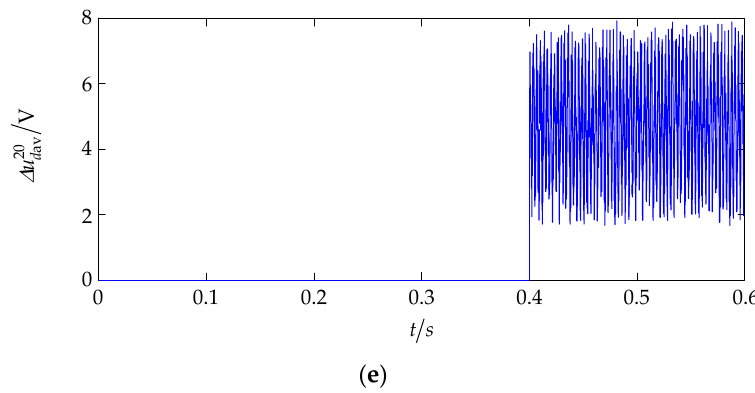
Figure 10. The simulation results (rated load, n ∗ = 900 r/min): ( a ) The three phase currents of two sets of windings; ( b ) The electromagnetic torque; ( c ) The d -axis voltages of two sets of windings; ( d ) The difference of the d -axis voltages between the set of faulty windings and the set of normal windings; ( e ) The average values for the difference of the d -axis voltages in the latest 20 sampling periods.